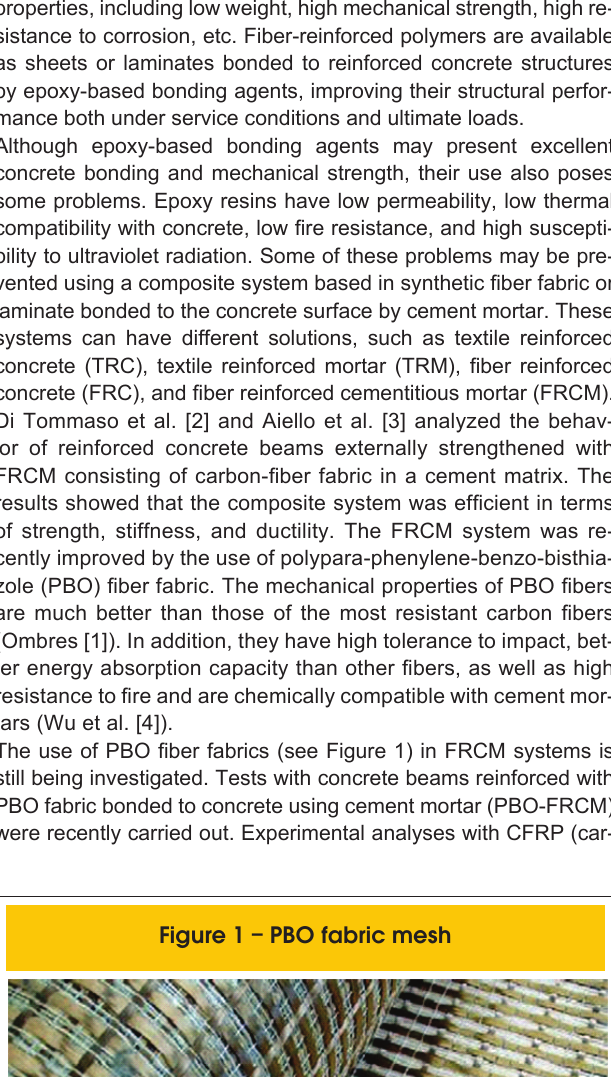
Figure 2 – Longitudinal and cross section of the beams tested by Ombres